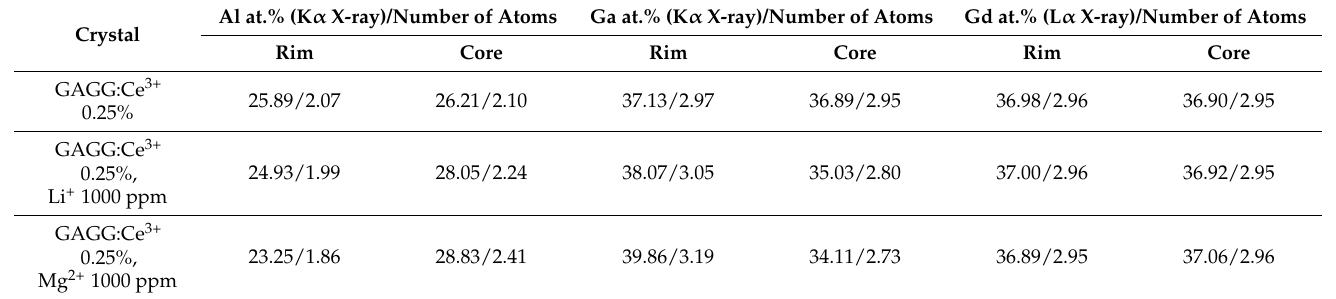
Table 1. EDS elemental analysis of the crystal rim and core for Li + :Ce 3+ and Mg 2+ :Ce 3+ doped GAGG crystals, 300 K.